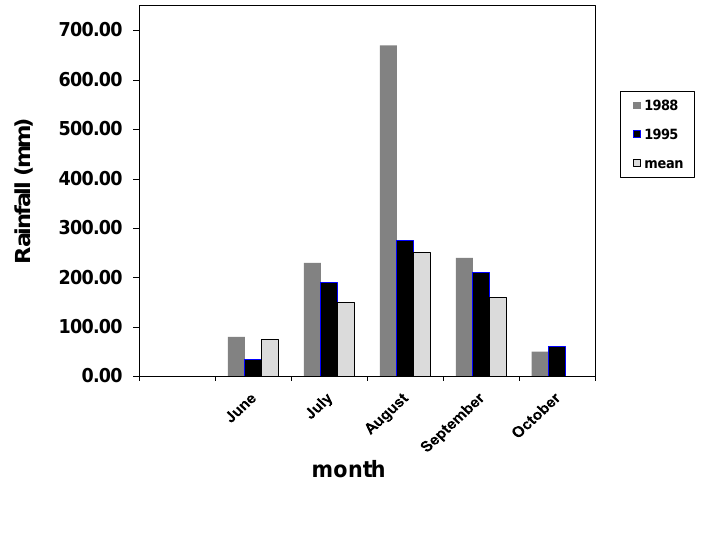
Figure 1. Monthly rainfall (mm) at Kerewan in 1988, 1995 and the average for the period 1949 to